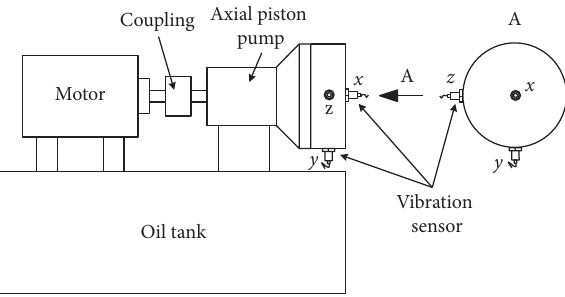
Figure 12: Vibration sensor layout.